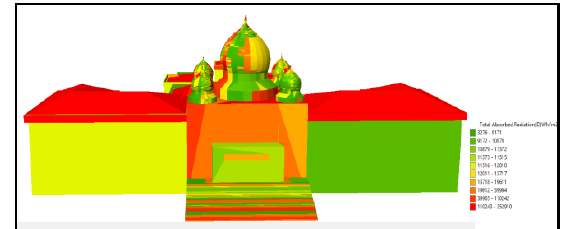
Figure 14. The simulation of heat absorb after alter the position The heat absorbed at original orientation has low minimum value compared to heat absorbed at new orientation. However, its maximum value is higher than new orientation building. The mean for original position and altered position are 49135 W/m² and 49075 W/m² respectively. The mean of both analyses only has 60 W/m²